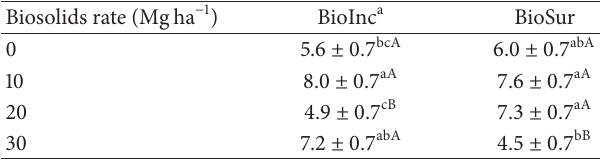
Figure1:Monthlyprecipitation(JunetoSeptember)atthestudysite from 2005 to 2008. Ejido Nuevo Delicias, Chihuahua.